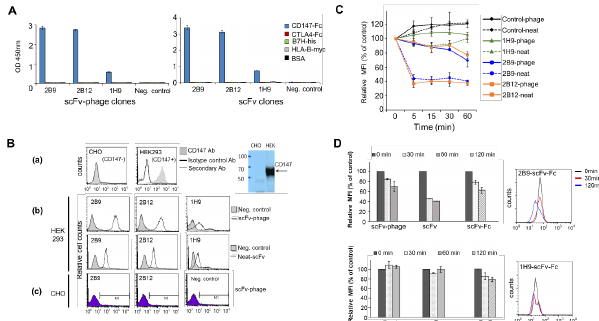
Figure 1. Analysis of anti-CD147 antibody specificity for CD147 and internalization of anti-CD147 in scFv-phage, scFv and scFv-Fc formats. ( A ) Binding specificity of the 2B9, 2B12 and 1H9 anti-CD147 scFv-phage and scFv for CD147 was analyzed by ELISA using recombinant CD147-Fc and irrelevant proteins in fusion with tag (Fc, His or c-Myc) and BSA were used as controls. ( B ) Analysis of scFv- phage and neat scFv binding to cell-surface CD147 by flow cytometry. ( a ) HEK293 and CHO cell lines are CD147-positive and CD147 negative cells, respectively. Cells were stained with commercial anti- CD147 (shaded area; GeneTex) or isotype control antibody (gray line) followed by FITC-labeled secondary antibody (Ab) (black line). CD147 protein in the cell lysate was confirmed by Western blot using an HRP-labeled secondary antibody and enhanced chemiluminescence detection system (Pierce). ( b ) Binding of 2B9, 2B12 and 1H9 anti-CD147 scFv-phage (normalized to 10 10 cfu) and neat scFv to CD147-positive HEK293. Cell surface-bound anti-CD147 antibodies were detected using anti- M13 phage Ab or anti-His antibodies for scFv-phage or neat scFv, respectively, with PE-conjugated secondary Ab. ( c ) Anti-CD147 scFv-phages and target irrelevant scFv-phage control did not bind to CD147 negative CHO cells. ( C ) 1H9, 2B9, and 2B12 antibody internalization into HEK293 using normalized scFv-phage and neat scFv formats. Change in mean fluorescence intensity (MFI) of antibody relative to the control was quantified to determine the level of antibody internalization (see Materials and Methods). ( D ) Comparison of 1H9 and 2B9 internalization of phage-scFv, scFv and scFv-Fc formats into HEK293. Representative histograms for 2B9 scFv-Fc (1.25 µ g / mL) and 1H9 scFv-Fc (5.0 µ g / mL) are shown. Negative controls are target irrelevant scFv-phage or scFv antibodies. The results represent the mean ± SD from at least four independent experiments performed in